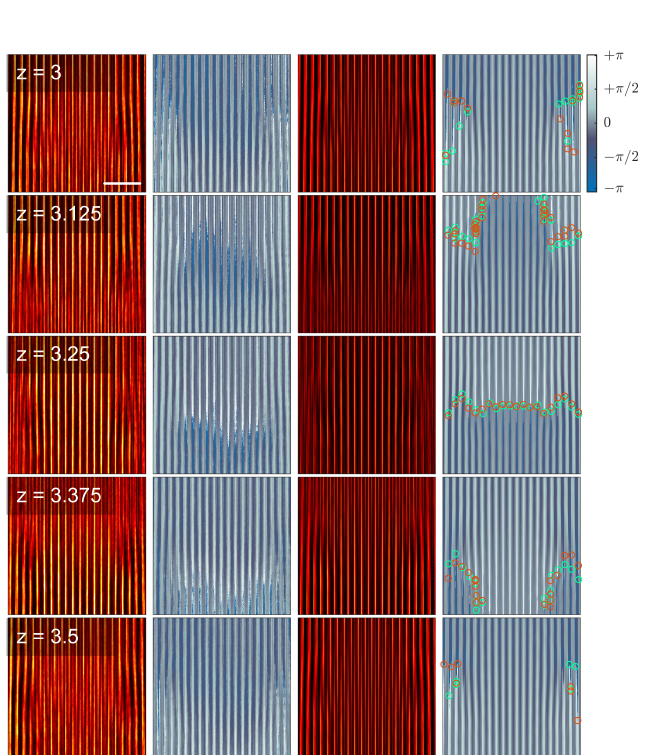
Figure 2. Experimental (the first column) and calculated (the third column) intensity profiles, and retrieved (the second column) and calculated (the fourth column) phases of diffracted field at different distances (in units of z T ) from FSG with p = + 1. Circles mark positive (green) and negative (red) optical singularities. Scale bar corresponds to 50 µ m.